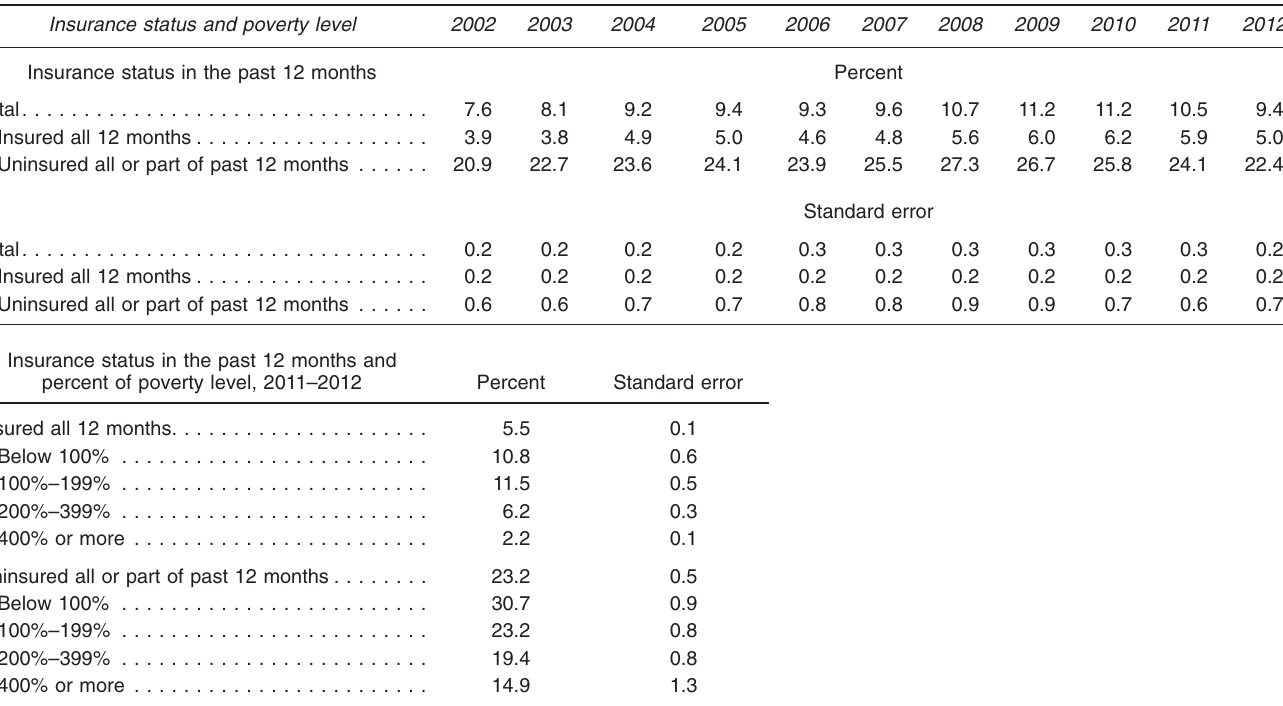
Data table for Figure 23. Nonreceipt of needed prescription drugs in the past 12 months due to cost among adults aged 18–64, by insurance status and percent of poverty level: United States, 2002–2012 Excel and PowerPoint: